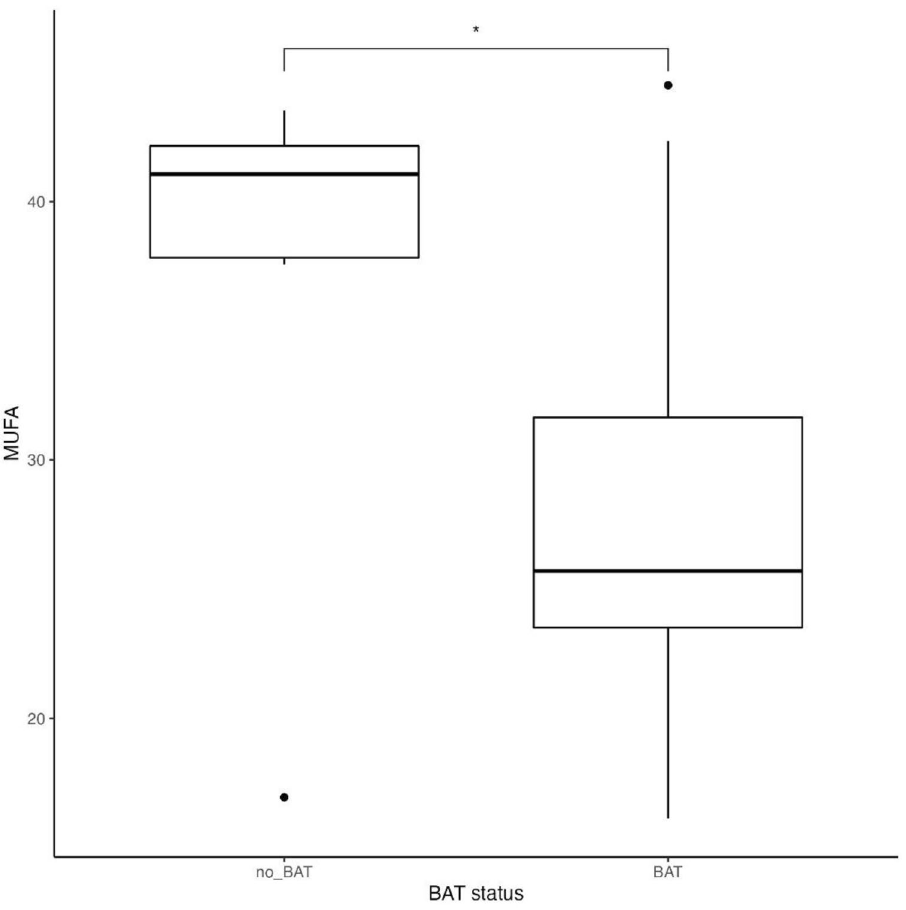
Figure 4. MUFA intake in subjects dependently on BAT status (p =